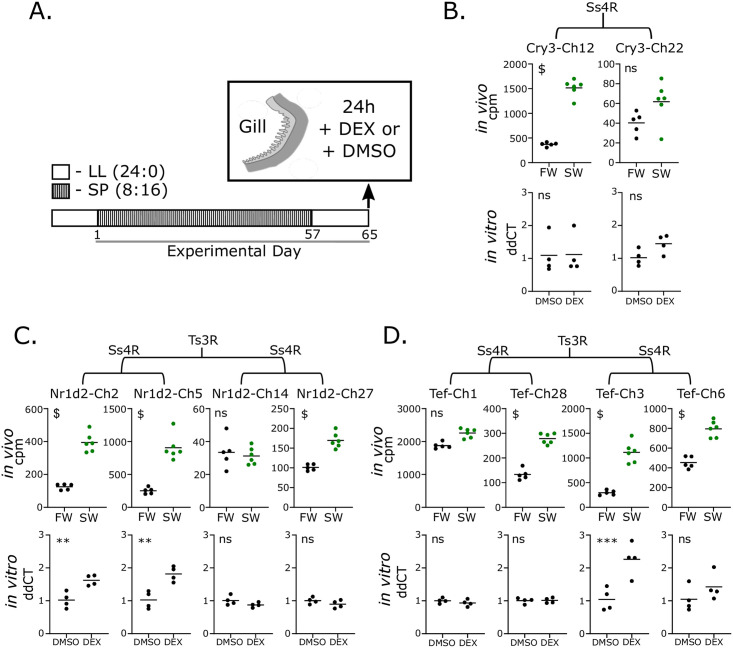
In-vitro validation of glucocorticoid stimulated clock ohnologue expression.A. Dexamethasone-dependent transcript regulation experimental design. After photoperiod manipulation in vivo, whole gill arches (n = 4) were removed and treated for 24 hours with the glucocorticoid receptor agonist dexamethasone (DEX), or dimethlysulphoxide (DMSO; vehicle control). B. Comparative regulation of Cry3-Ch12/22 taken from in vivo sea-water stress experiment and in vitro dexamethasone treatment. C. As in B for Nr1d2-Ch2/5 & Nr1d2-Ch14/27. D. As in B for Tef-Ch1/28 & Tef-Ch3/6. Braches indicate phylogenetic relationship between gene sets.